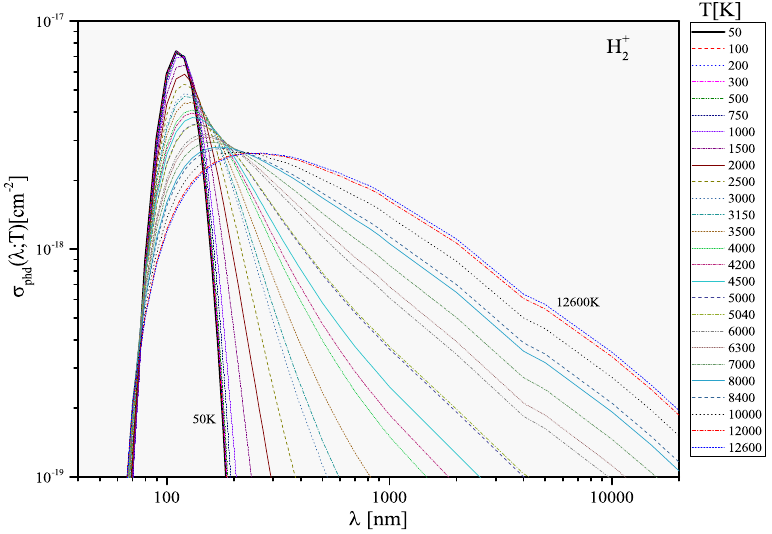
Figure 4. The behaviour of the averaged cross-section σ phd ( λ , T ) for photodissociation of the H + molecular ion, as a function of λ and T .